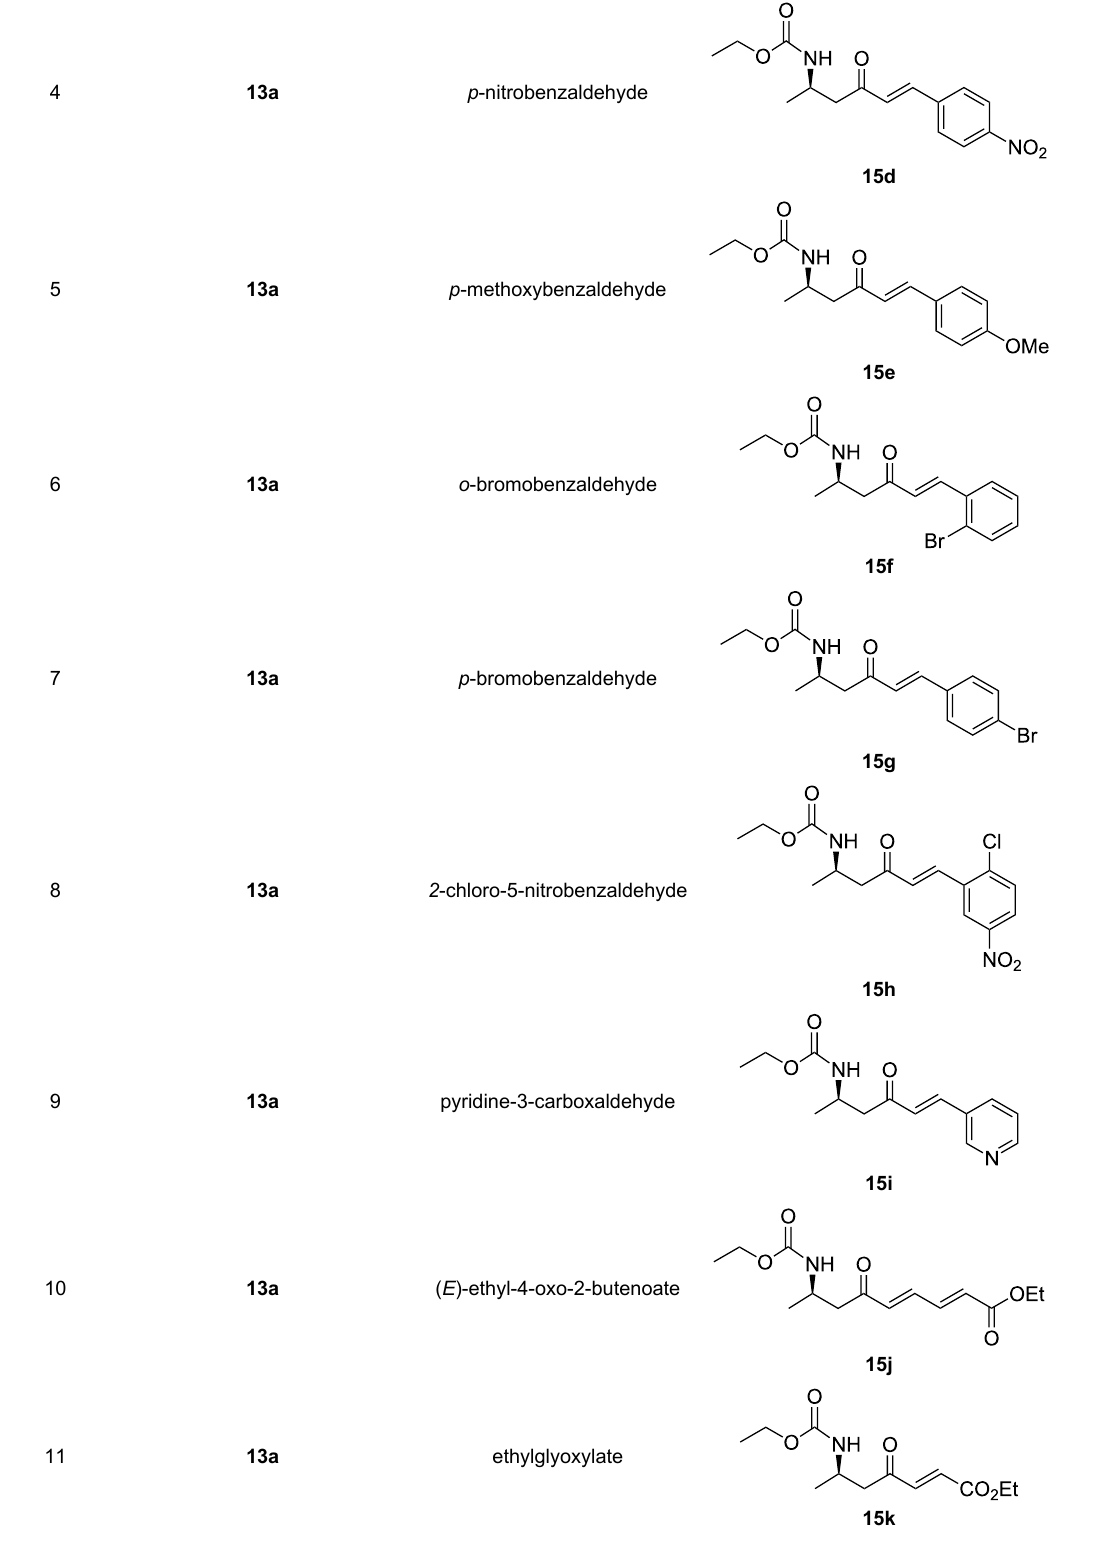
Table 3: Formation of the β ’-amino- α , β -unsaturated ketones 15 under Ba(OH) 2 conditions. (continued)